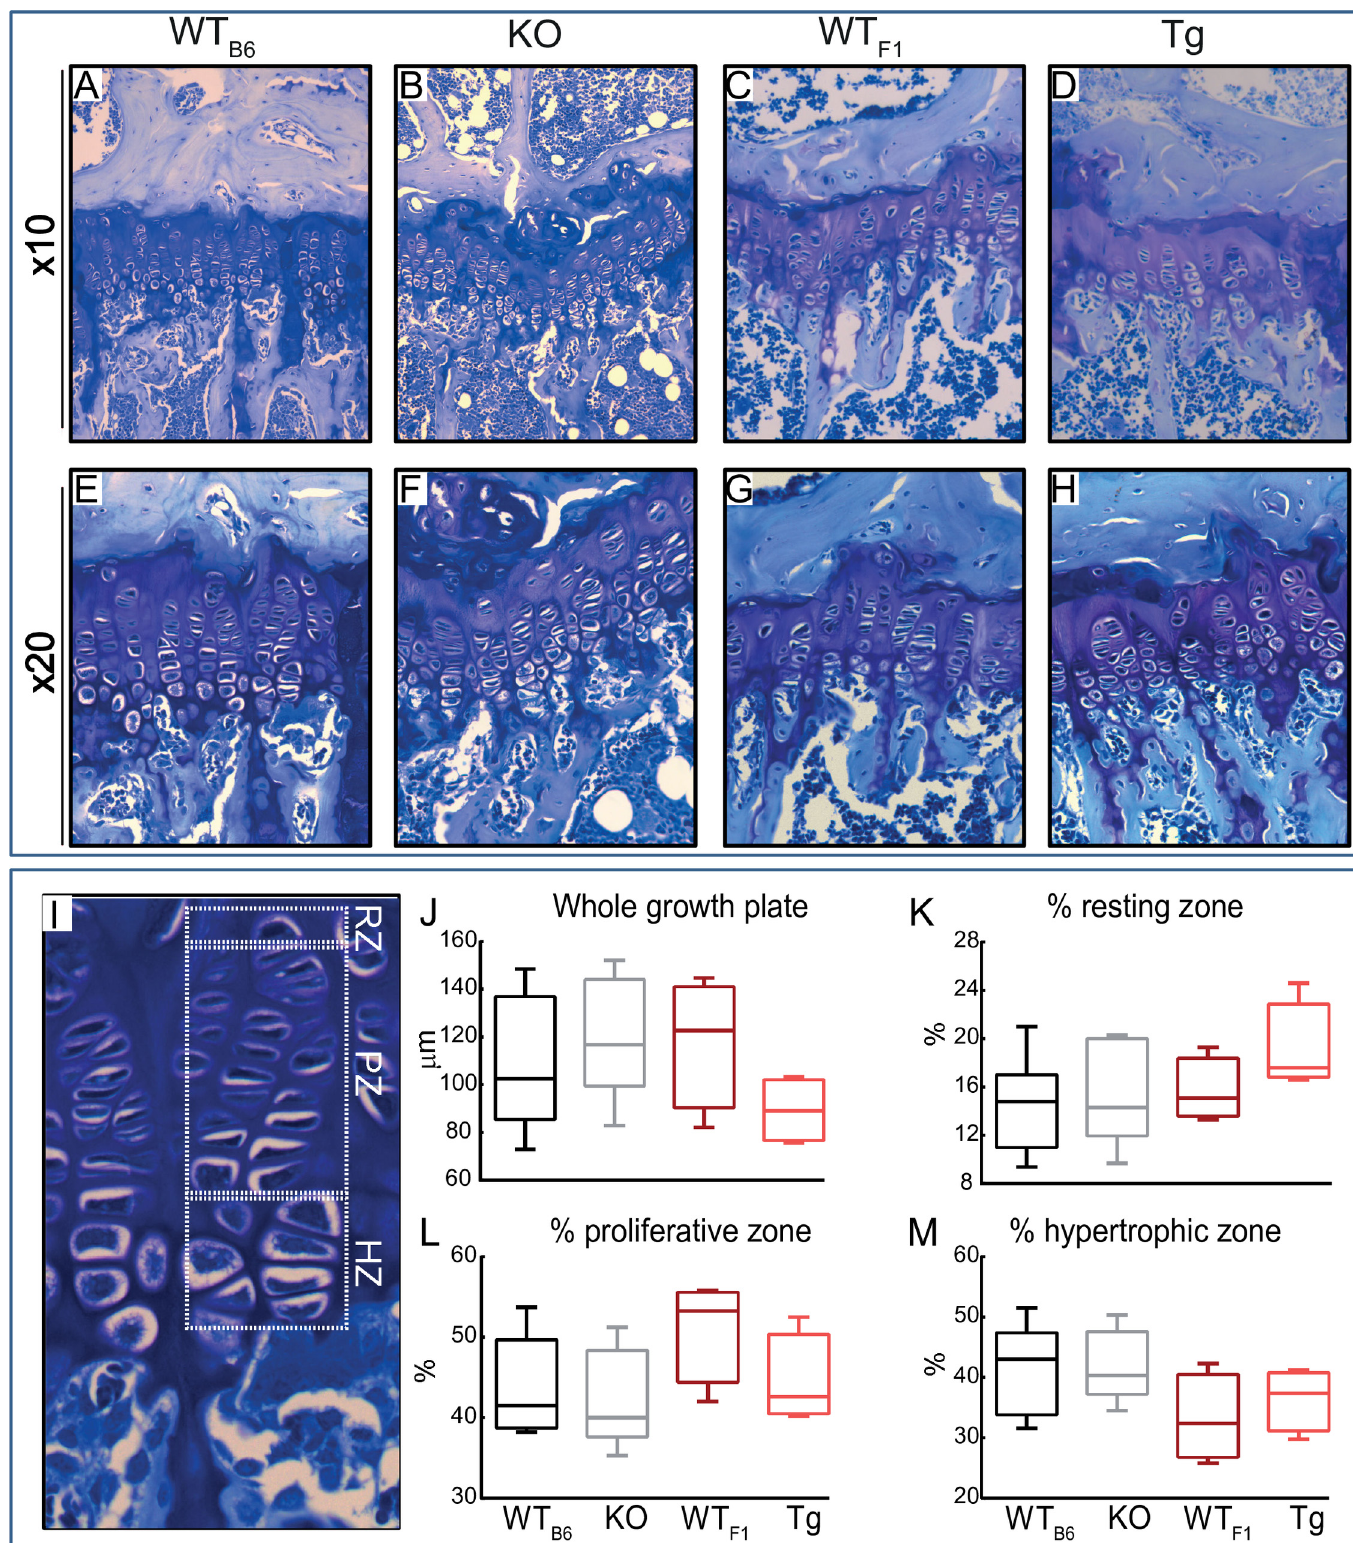
Fig 2. Timp-3 deficiency and transgenic chondrocyte-specific overexpression do not alter thickness of different zones in growth plate. Representative images of toluidine blue stained sections from WT B6 (A and E), KO (B and F), WT F1 (C and G) and Tg (D and H) mice showing overall